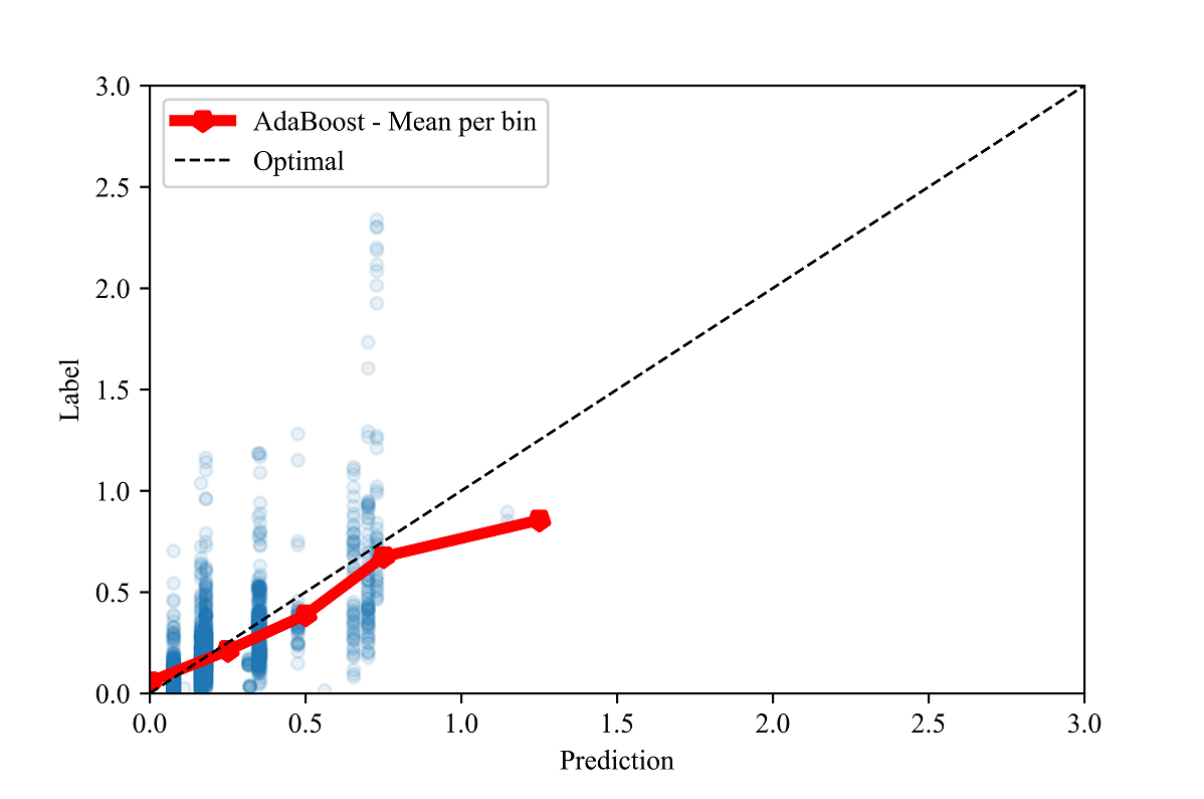
Figure 3. Calibration plot between the labels and predictions for the extrapolation validation method, with the mean of each prediction bin of size 0.25.